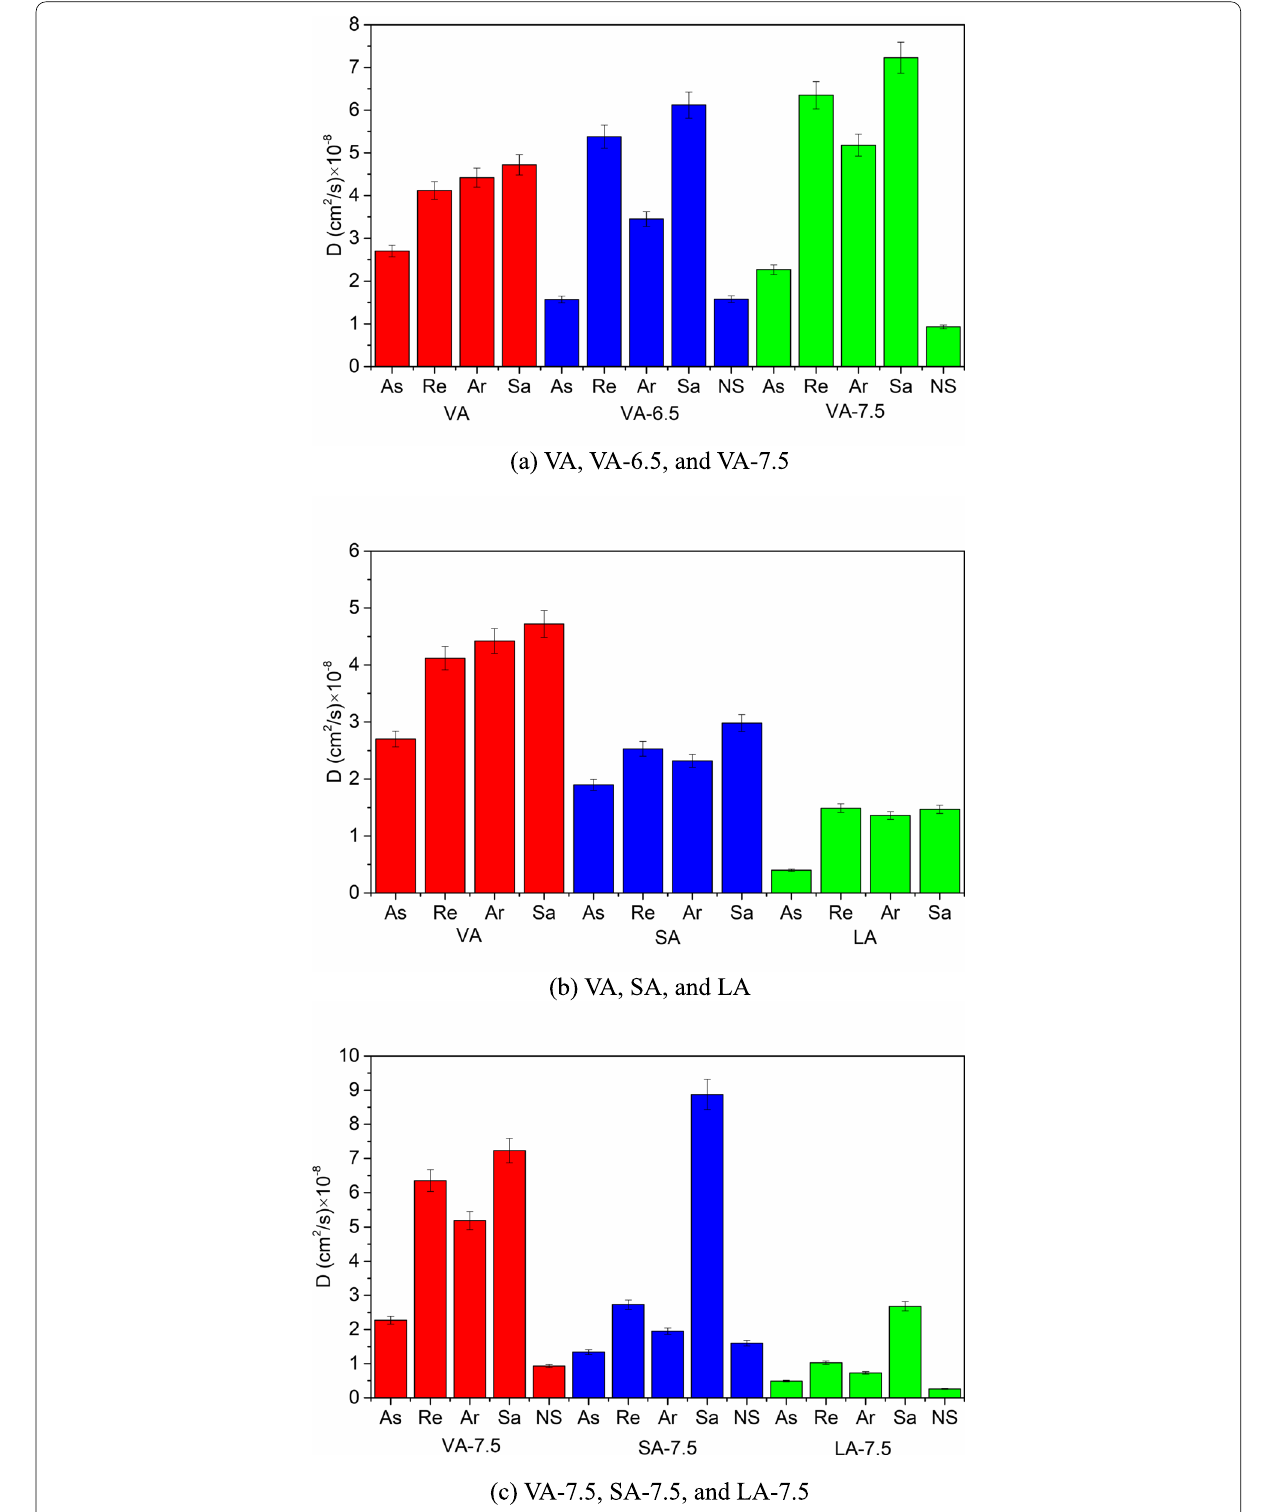
Fig. 18 Comparison of the Molecular Diffusion Coefficient of the Components in the Asphalt Models at 333 K: ( a ) VA, VA-6.5, and VA-7.5, ( b ) VA, SA, and LA, and ( c ) VA-7.5, SA-7.5, and LA-7.5. It shall be noted that As is for asphaltene, Re is for resin, Ar is for aromatic, Sa is for saturate, and NS is for nano-SiO